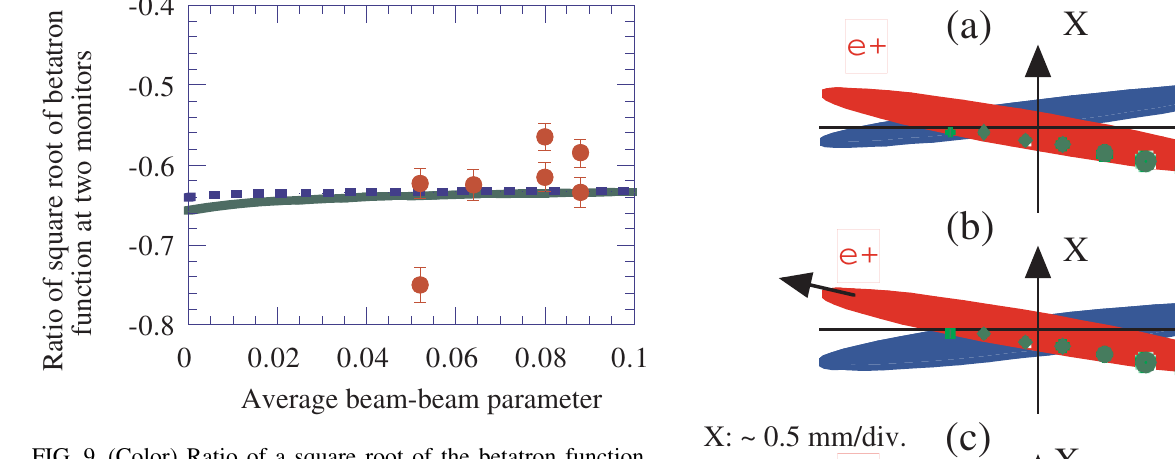
FIG. 9. (Color) Ratio of a square root of the betatron function between two monitors, LER-1/LER-2, as a function of the average beam-beam parameter. The green solid line is the calculated ratio with a fractional tune of 0.540, and the blue dashed line with a tune of 0.510, and the red dots with error bars are measured ones.